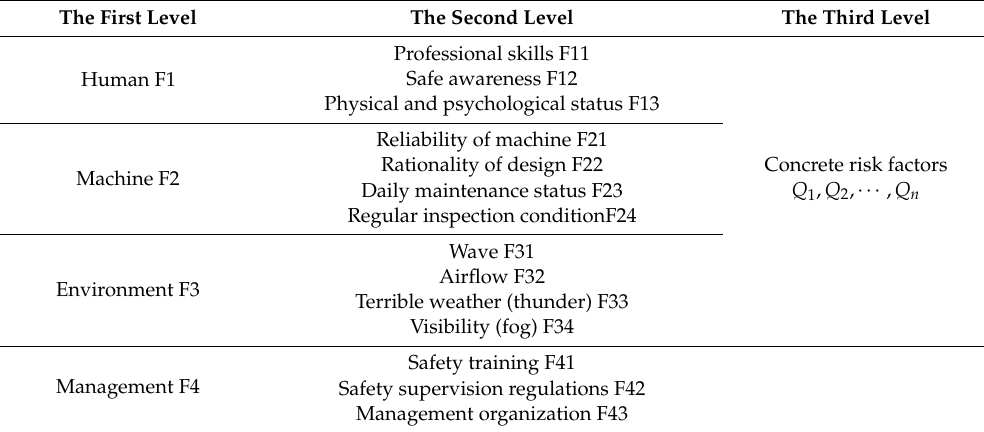
Table 1. The hierarchical relationship of risk